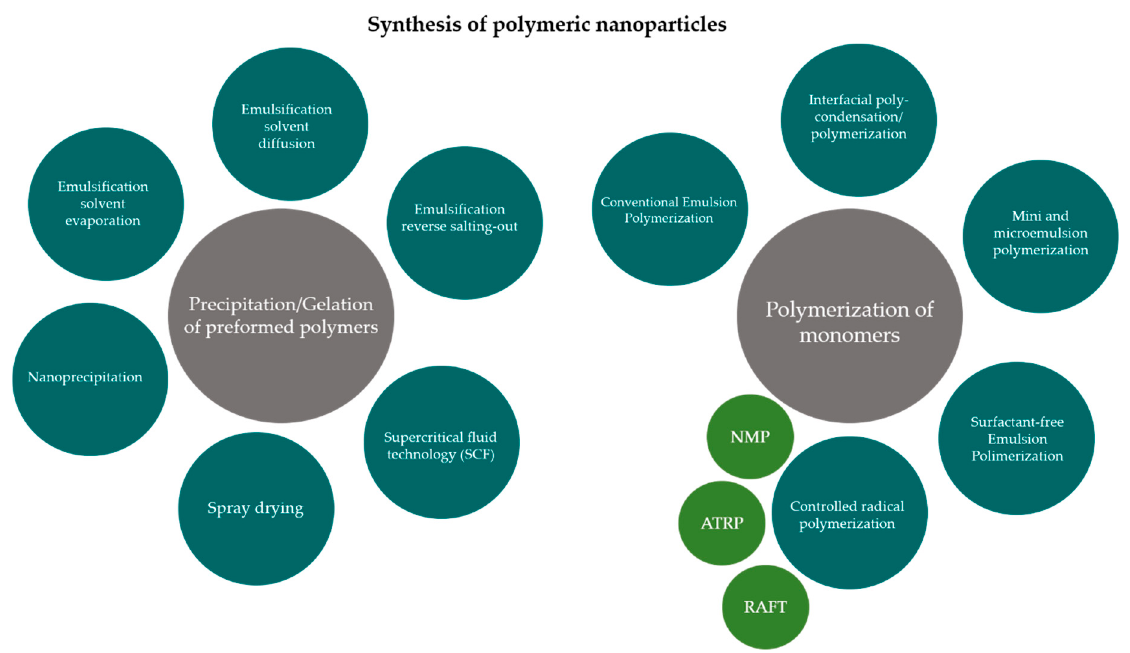
Figure 2. Diagram representing the options of production methods to obtain polymeric nanoparticles. Abbreviations: NMP (nitroxide-mediated polymerization); ATRP (atom transfer radical polymerization); RAFT (reversible addition and fragmentation transfer chain polymerization).